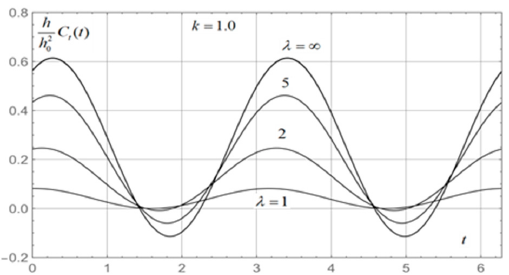
Figure 8. Instantaneous thrust (suction) force coefficient for a flat rectangular wing of finite aspect ratio λ at different Strouhal numbers.